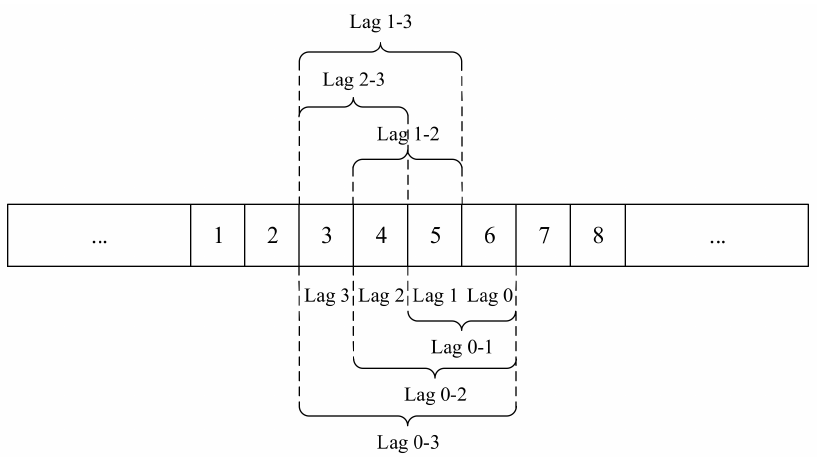
Figure 2. Sketch illustrating how different periods of lag data were reconstructed using the average calculated over various time